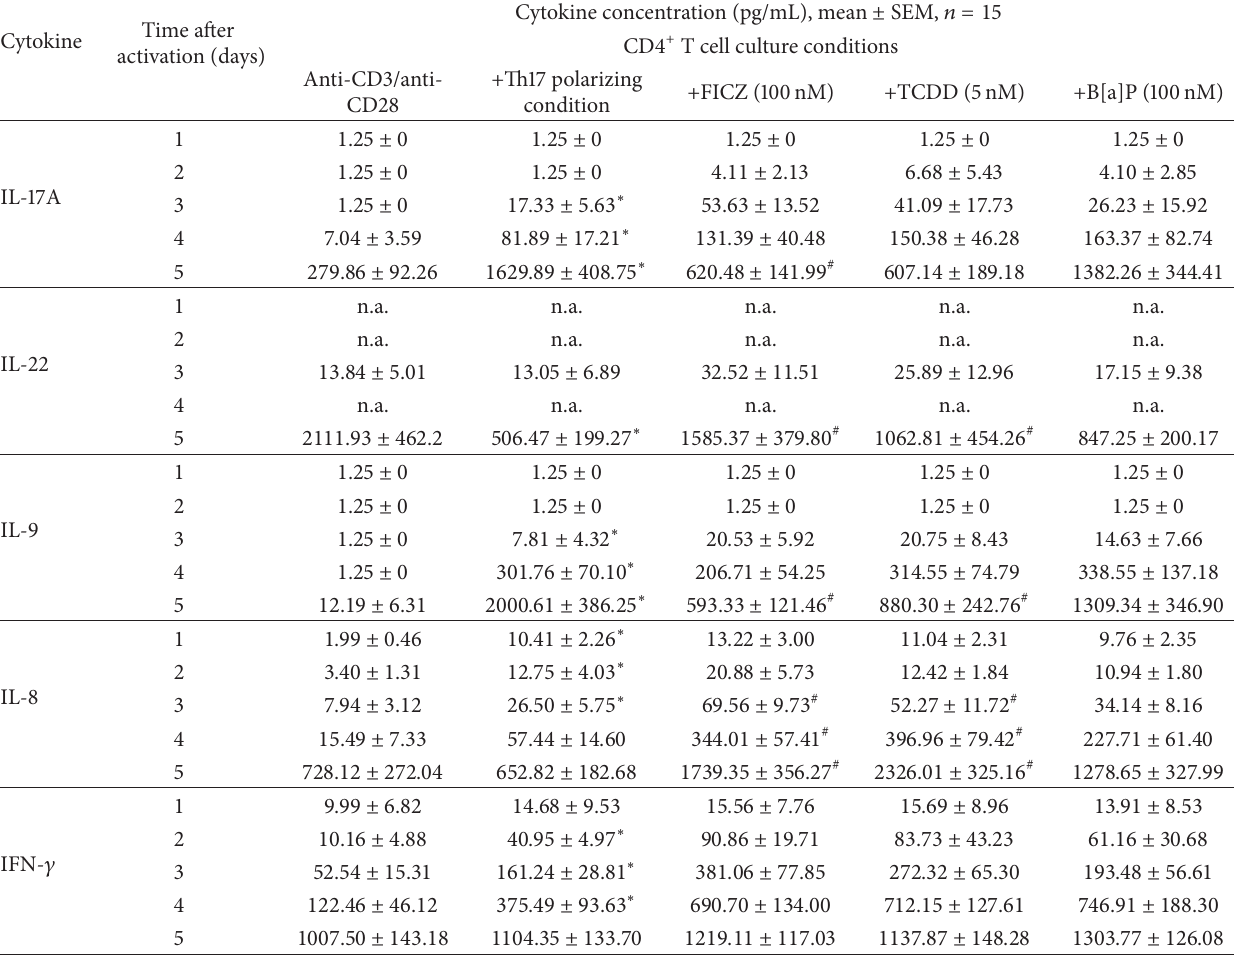
Table 2: Absolute concentration of cytokines (pg/mL) secreted by CD4 + T cells cultured under activation (anti-CD3/anti-CD28), Th17 polarizing conditions (TGF- 𝛽 , IL-1 𝛽 , IL-23), and with the AHR ligands FICZ, TCDD, and B[a]P measured by CBA (IL-17A, IL-9, IL-8, and IFN- 𝛾 ) and ELISA